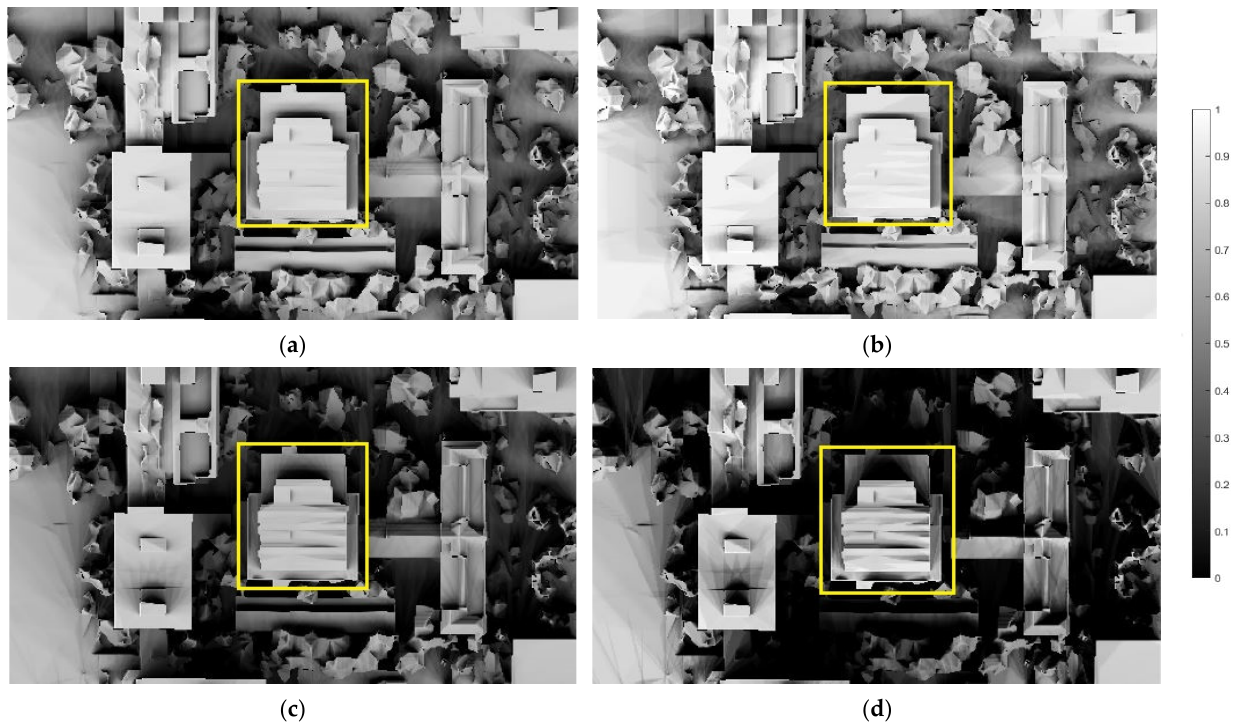
Figure 12. Average brightness score for the CAM building in ( a ) spring, ( b ) summer, ( c ) fall, and ( d ) winter.